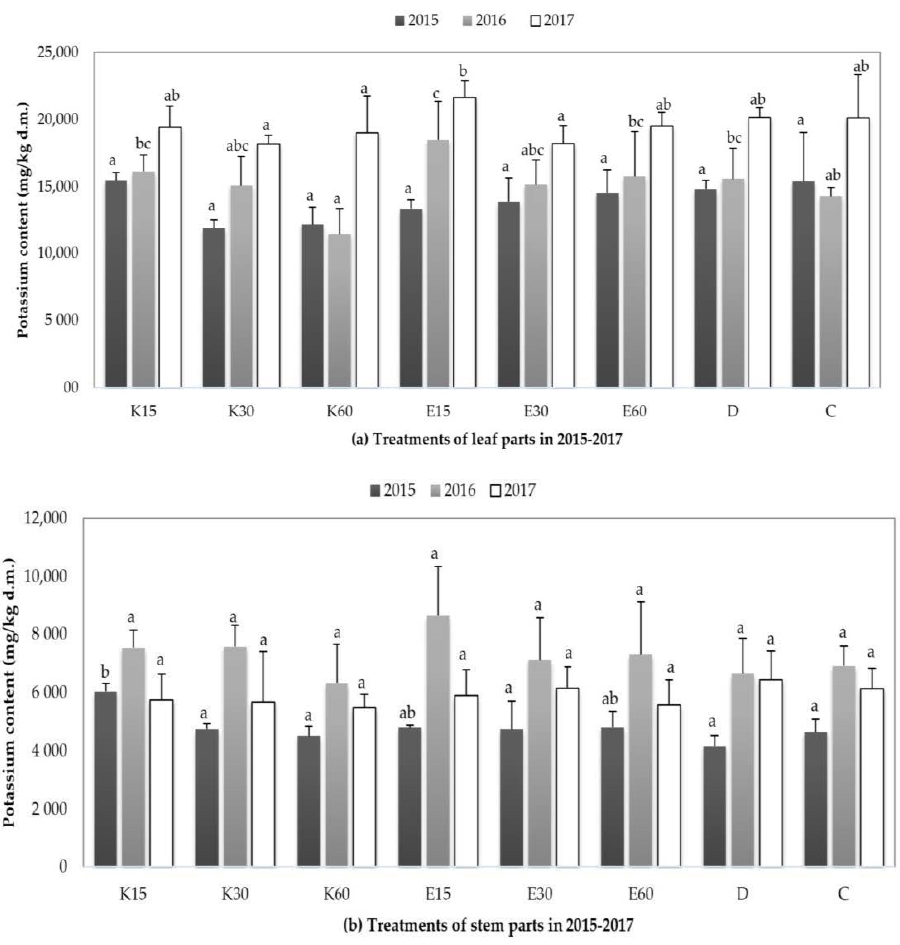
Figure 4. Potassium content values of leaf and stem parts from 2015 to 2017: ( a ) potassium content values of leaf parts in a year of 2015–2017; ( b ) potassium content values of stem parts in a year of 2015–2017. Average potassium content data are presented from eight treatments. Results are means ± SD, n = 6. Different letters introduce significant differences among irrigation water qualities for the three vegetation season, confirming to the Tukey’s test at p ≤ 0.05.